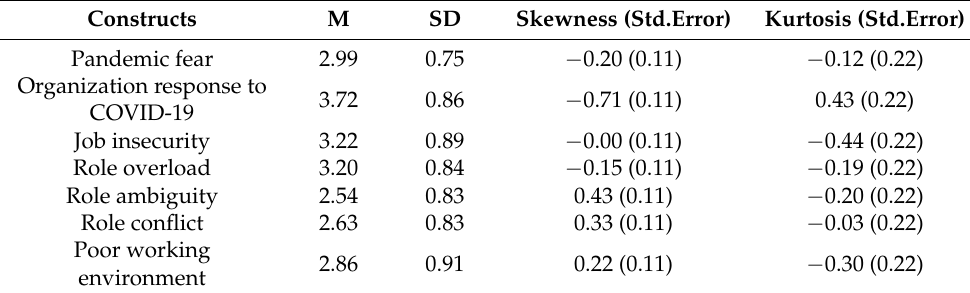
Table 2. Descriptive statistics of